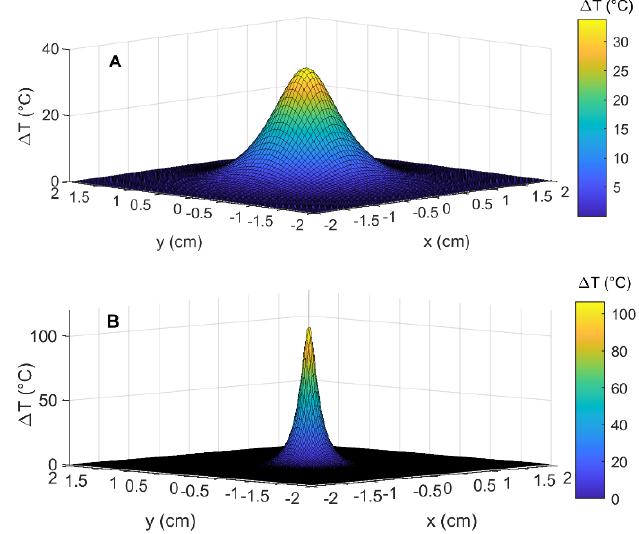
Figure 10. Temperature distribution in the xy -plane within the tumor at 2 mm distance from the tip of the laser source and placed in the direction of laser beam and at 30 s after irradiation for ( A ) pancreas and ( B ) pancreas loaded with 12.5 µg/mL GNRs. A laser power of 2.1 W was used to obtain these results.